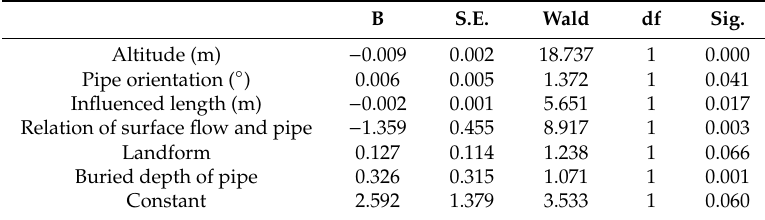
Table 6. Variables in the regression equation for erosive damage caused by surface flows.